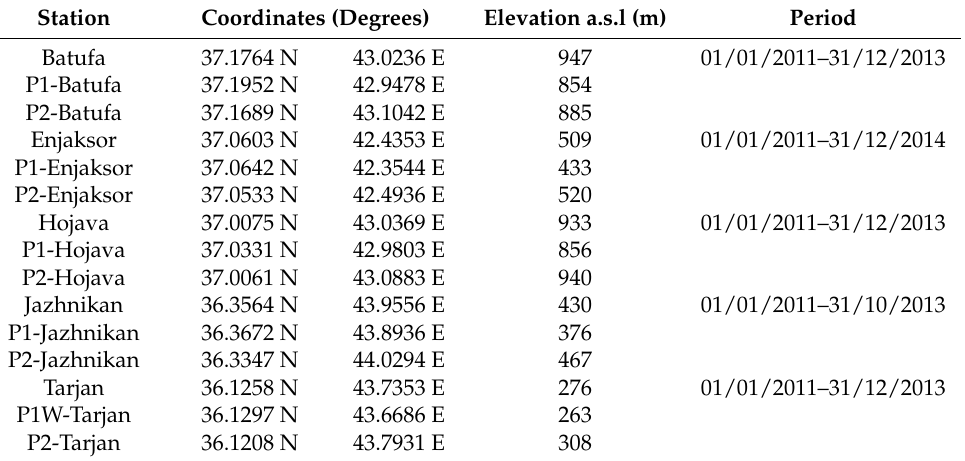
Table 2. Automatic stations with hourly GHI Vaisala QMS101 Pyranometer.